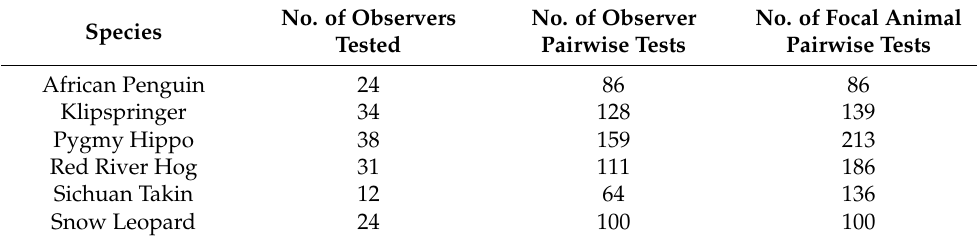
Table 1. The number of observers tested, and reliability test sessions conducted across six species monitored as part of an on-going behavior monitoring